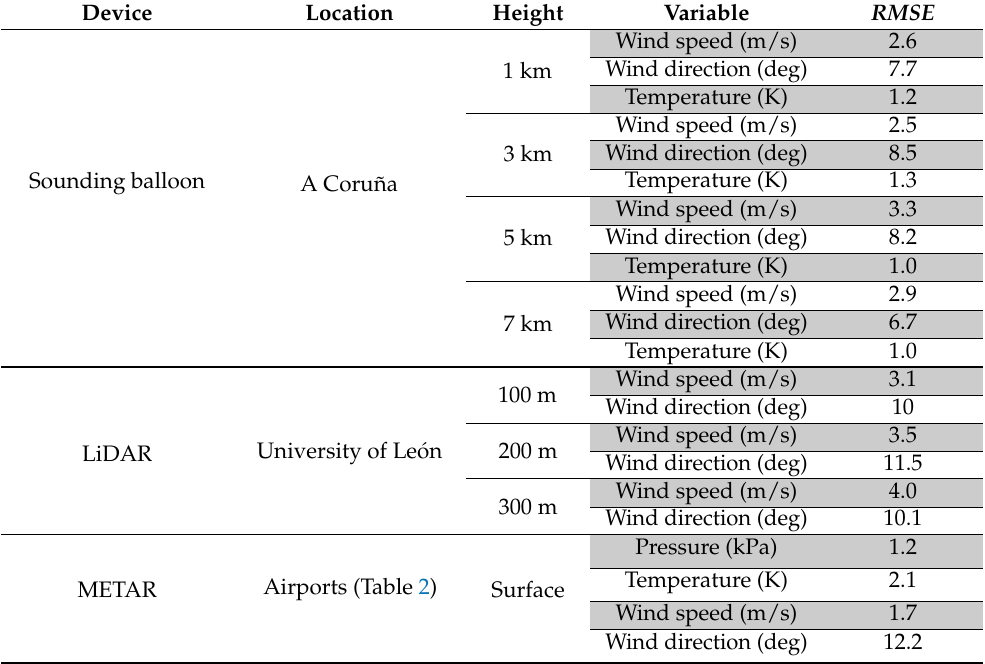
Table 3. Results of the mesoscale model